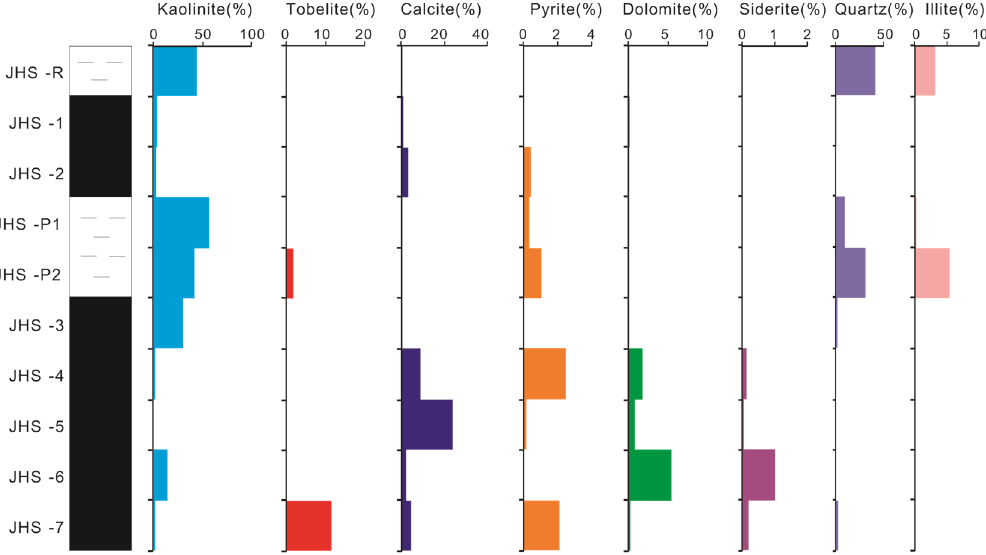
Figure 15. Vertical variations of primary minerals expressed as percentages of each whole-coal or rock sample in the Jinhuashancoal mine.